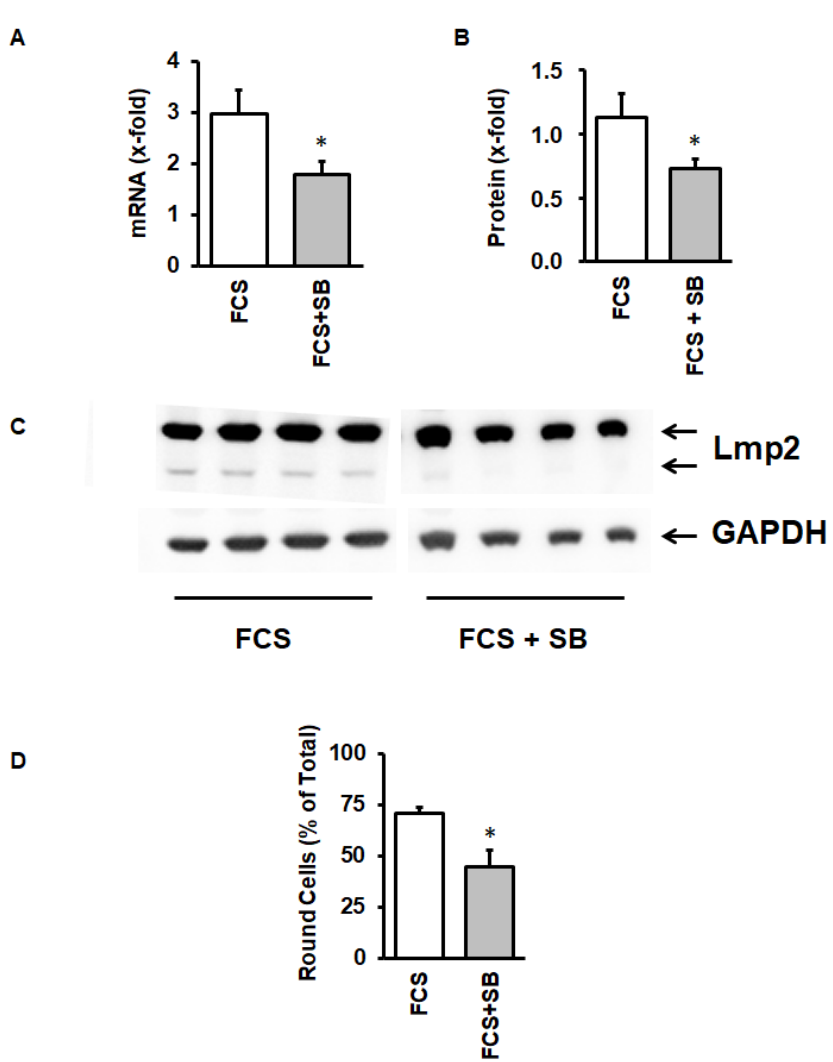
Figure 6. E ff ect of the p38 MAP kinase inhibitor SB202190 (SB) on LMP-2 mRNA expression ( A ), protein expression ( B , C ), and cell rounding ( D ) of cultured cardiomyocytes. Data are means ± SD from n = 4 preparations. *, p < 0.05 vs. FCS.